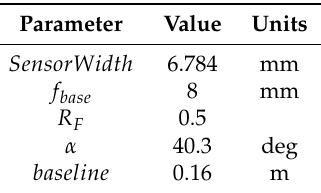
Table 4. FOV Properties.